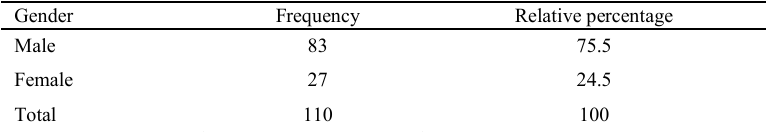
Table 1: Relative distribution of respondents by gender